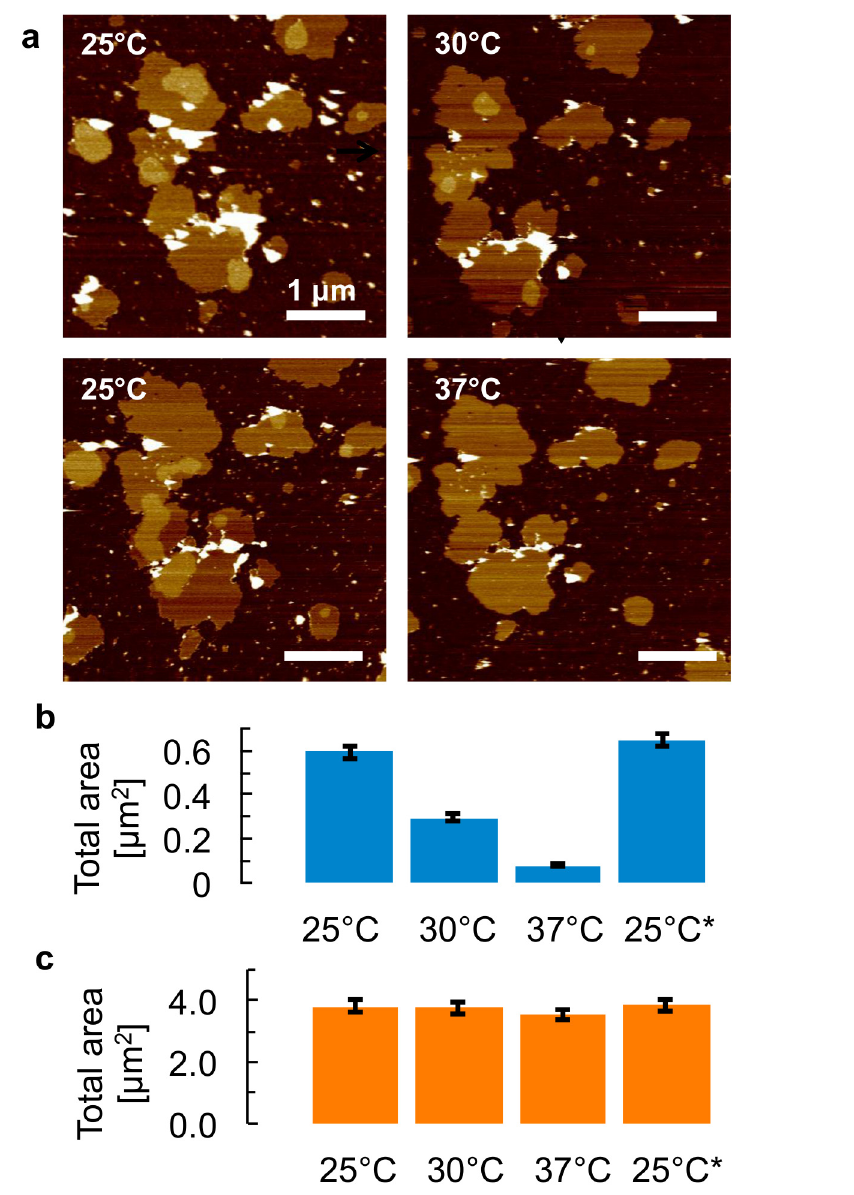
Fig 2. Reversible dissolution and formation of microdomains. a , AFM topography of isolated membrane samples in buffer solution, for a thermal cycle in which the temperature is first increased from 25°C to 30°C and then 37°C, followed by a decrease back to 25°C. Arrows indicate the sequence of the images. Vertical (color) scale for all AFM images: 9 nm, see also scale bar in Fig 1. b , Histogram of the surface area of the microdomains observed on the membrane patches in (a), demonstrating a shrinking of microdomains for higher temperatures and a full recovery at the end of the thermal cycle (25°C * ). c , Histogram of the total surface area of all patches that are fully included within the frames displayed in (a), showing that the absolute changes in total patch area are small compared to the absolute changes in microdomain area over the thermal cycle. Error bars = 5% (see